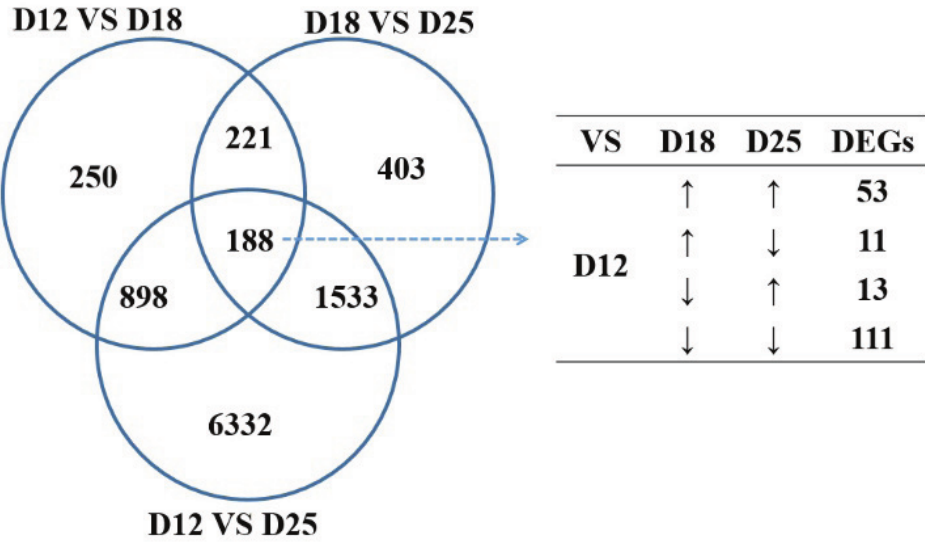
Figure 2. Differentially expressed genes (DEGs) of the endometrium for the three periods of